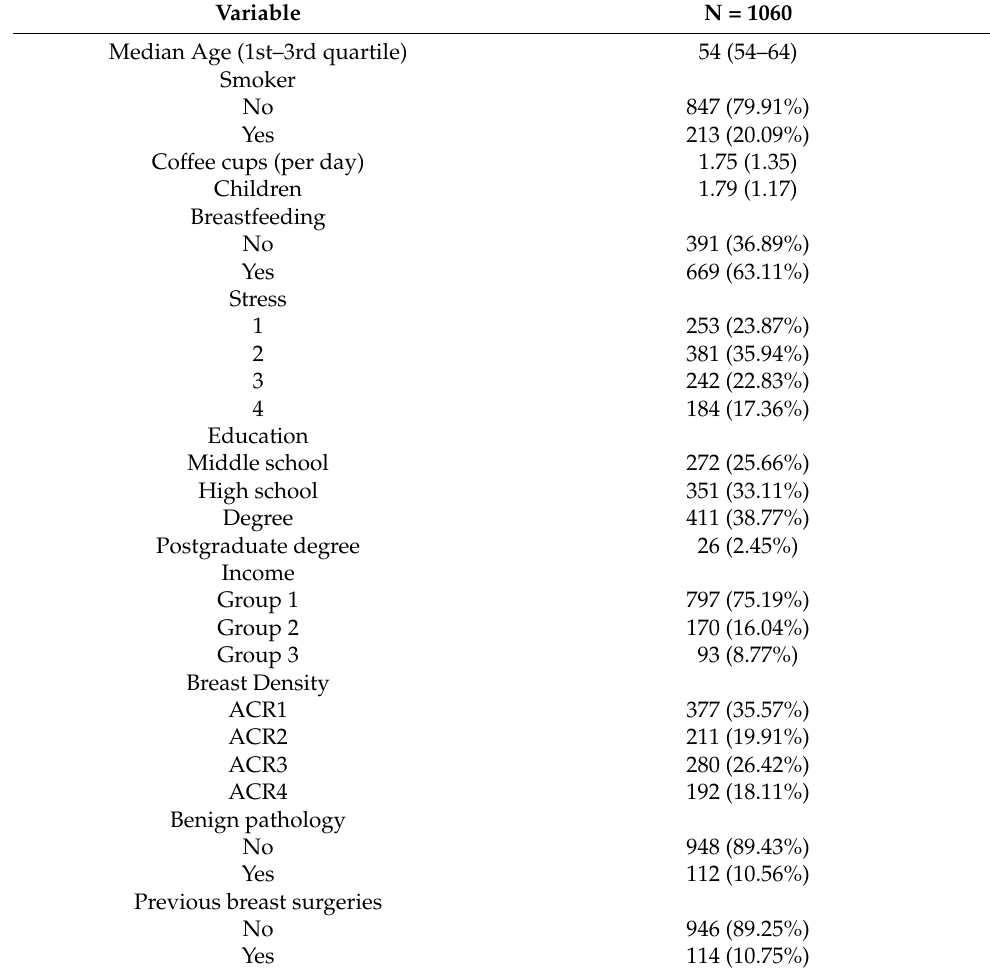
Table 1. Demographic characteristics of the study